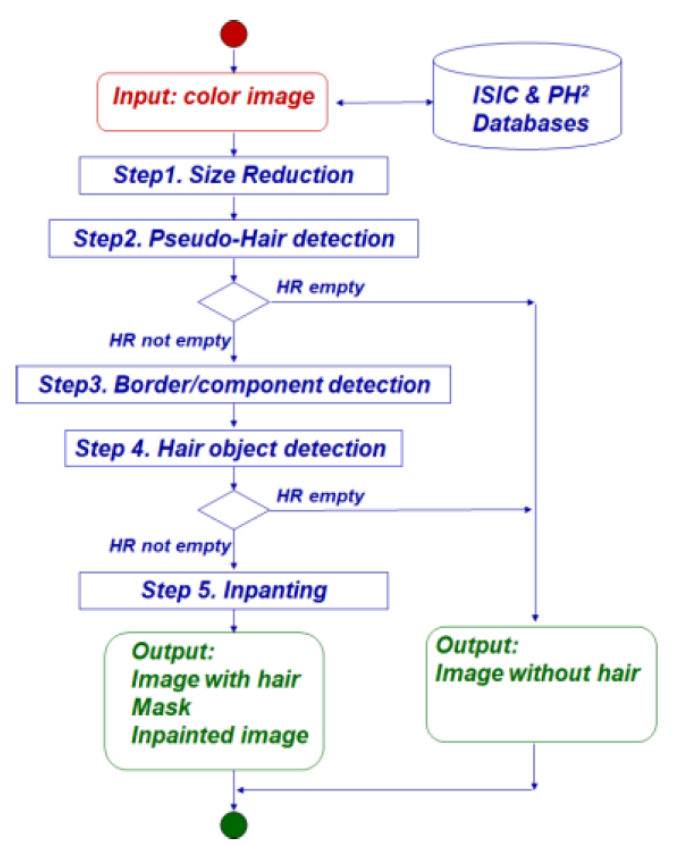
Figure 2. Flowchart of the proposed method (HR-SSC).